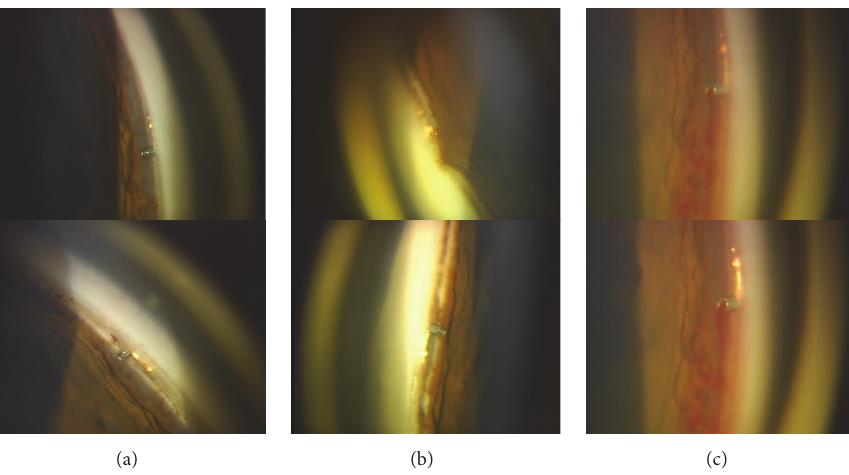
Figure 3: Gonioscopical photographs after two iStents’ implantation in the present study. (a) The upper stent (GTS100R) in the left eye was implanted upwardly using clockwise rotation, that is, against gravity. No malposition was observed. The lower photograph of the same eye shows the lower stent (GTS100L) implanted downwardly using counterclockwise rotation. (b) Obstruction due to the iris was only observed in one of the two stents. The upper stent (GTS100L) in the right eye is obstructed, while the inlet of the lower stent (GTS100R) is open. (c) Blood reflux from the upper stent (GTS100R) was observed in the same eye as (a) immediately after the placement of the gonioscopy. The upper and lower photographs show the time